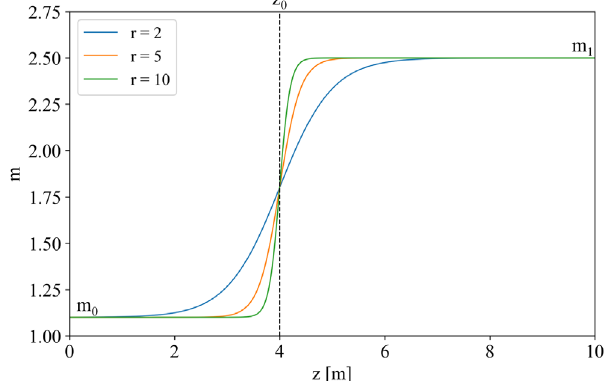
FIG. 3. Analytic function used to describe the modulation along the gentle buncher. m 0 and m 1 are the initial and final values of m ð z Þ , z 0 shifts the function along z, r defines the slope of the ramp.